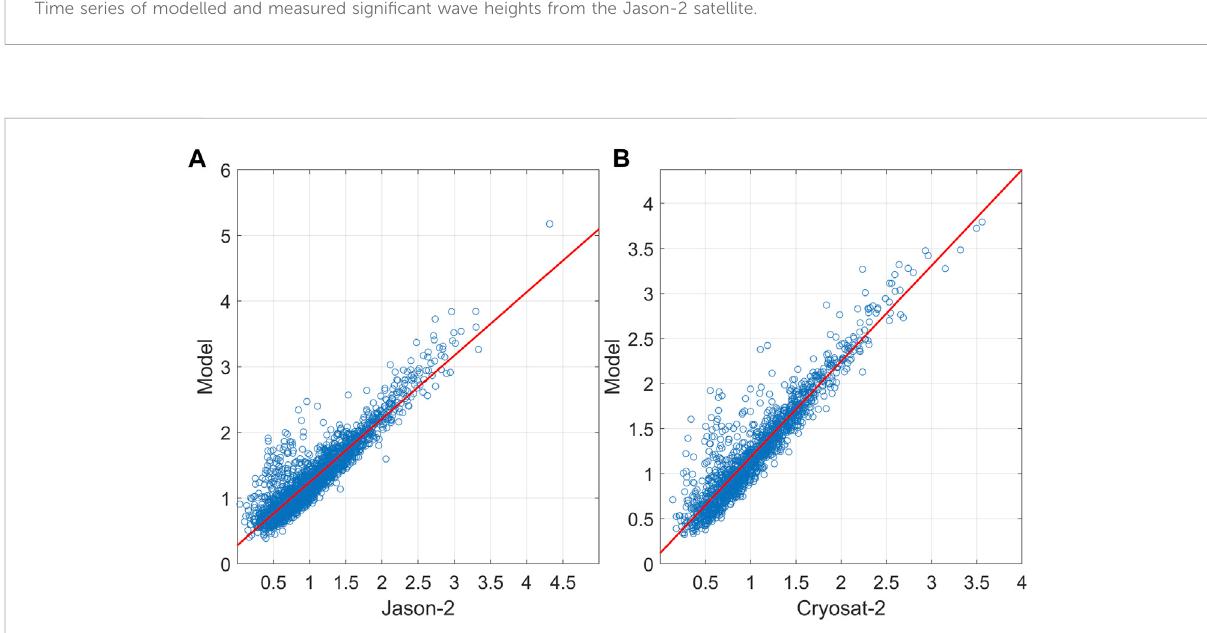
FIGURE 7 Scatter plots of the signi fi cant wave heights of modelled and satellite data: (A) Jason-2; (B)